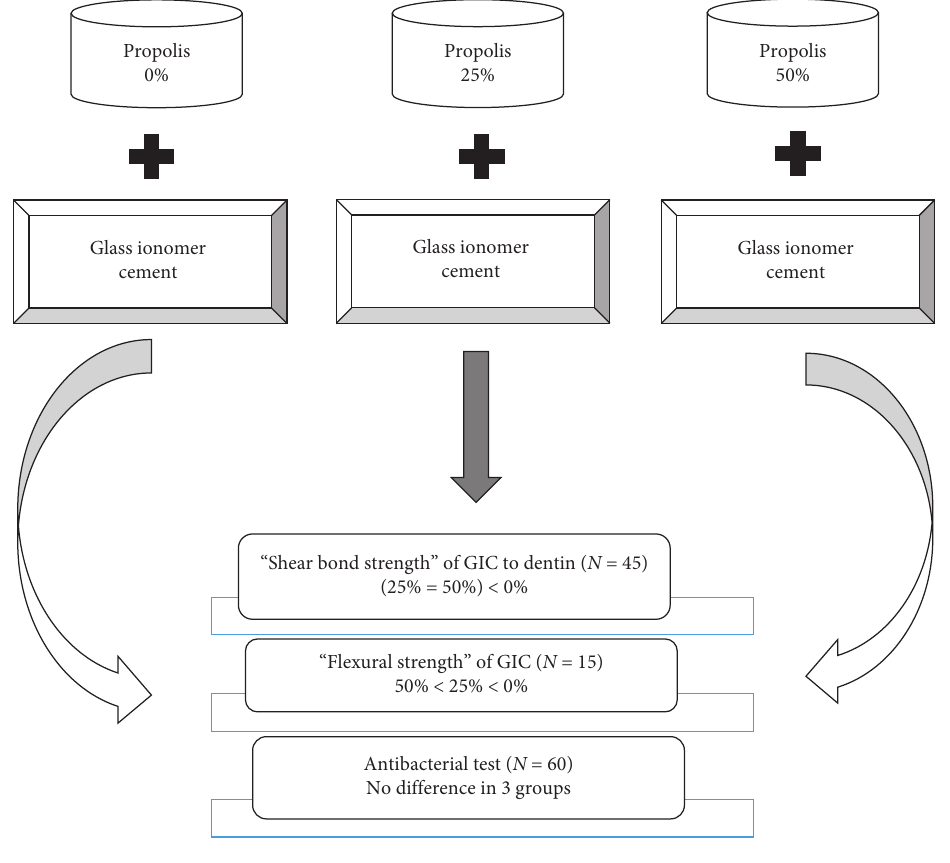
Figure 2: Experimental design and the results of the